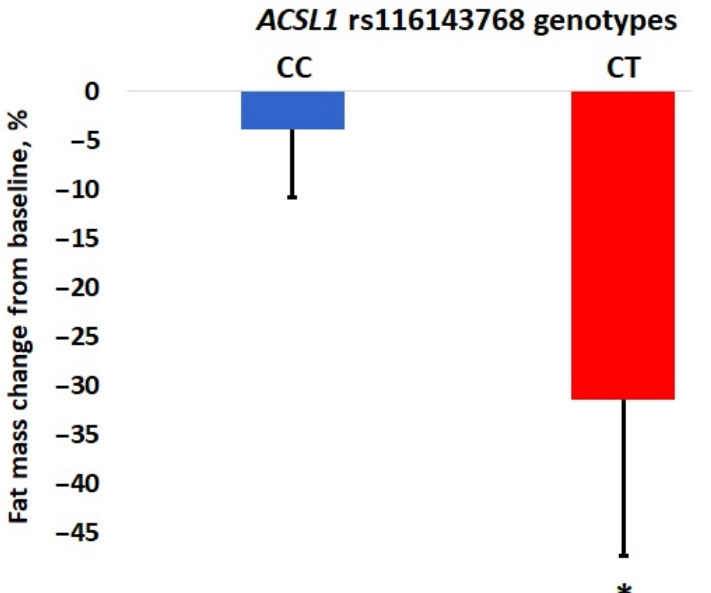
Figure 1. Differences in fat mass changes (%) in response to training between carriers of ACSL1